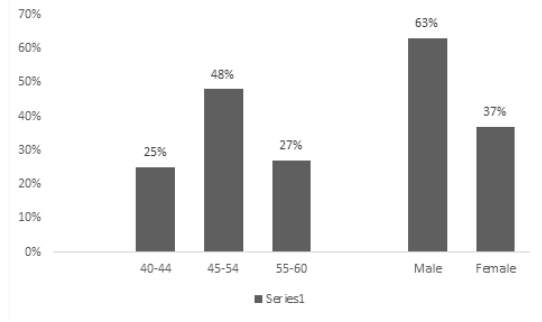
Figure 1. Distribution of epidemiological risk factors for the deve- lopment type 2 diabetes